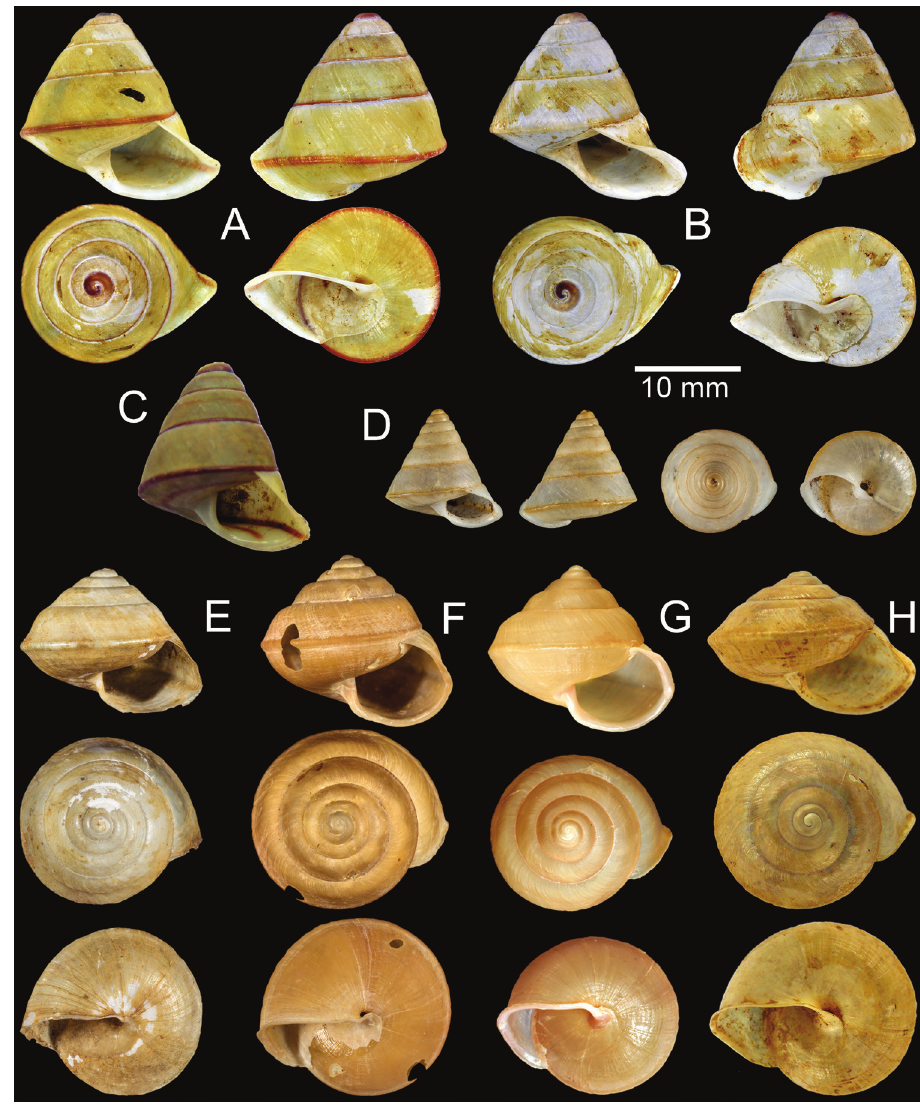
Figure 4. A–C Ganesella halabalah sp. nov. A holotype CUMZ 2608 B paratype CUMZ 2599 from the type locality and C paratype ZMB 53120 from Kelantan, Malaysia D Ganesella perakensis , syntype MNHN-IM-2000-1964. E–G Globotrochus onestera E lectotype MNHN-IM-2000-32456 F holotype of “ simonei Thach & Huber, 2017” MNHN-IM-2000-33206 and G specimen from Vietnam CUMZ 5218 H Globotrochus mellea , holotype RBINS/MT/